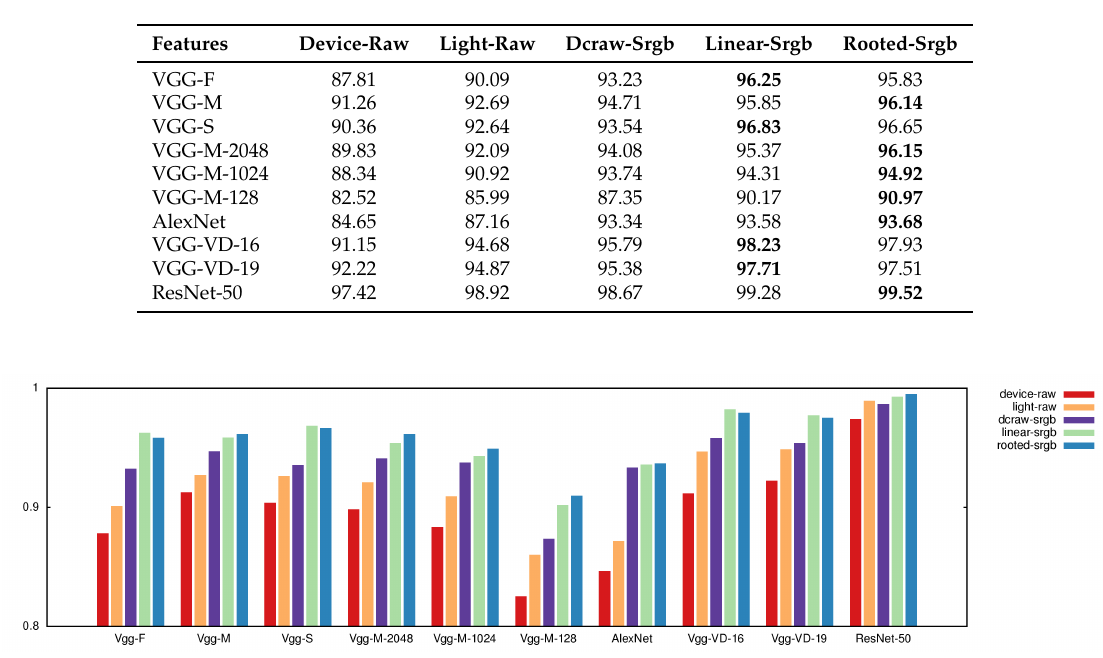
Figure 7. Classification accuracy obtained by each visual descriptor combined with each